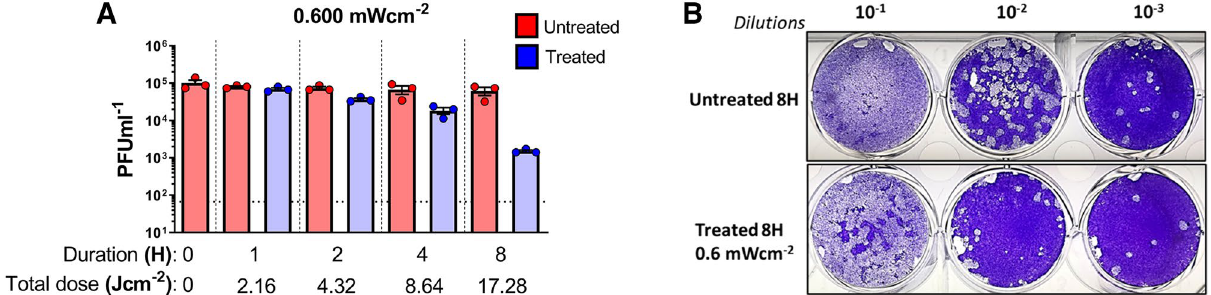
Figure 3. Inactivation of Influenza A virus in PBS by 405 nm irradiation. ( A ) A dose of 0.6 mW cm −2 was applied to irradiate samples at 405 nm over a course 8 h while sampling at 1, 2, 4 and 8 h (done in independent triplicates). Blue bars indicate treated samples and red bars correspond to the untreated equivalent that was left at the biosafety cabinet under the same conditions while not subjected to disinfecting irradiation. Data shown as PFUml −1 in triplicate assessed by plaque assay. ( B ) Plaque phenotype comparison from one independent experiment at an irradiation dose of 0.6 mW cm −2 . Fixed and blocked plaques were stained using crystal violet. Data show in here are from three independent replicates (Mean + SEM).